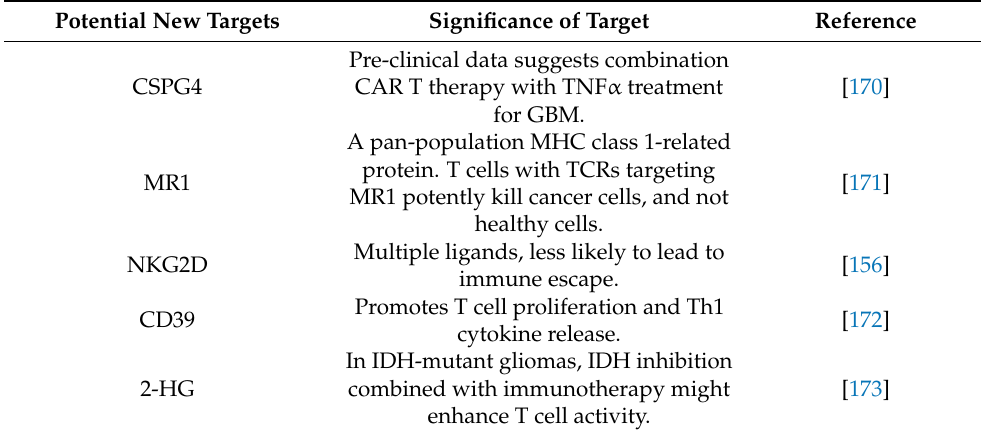
Table 3. Experimental targets for future GBM cancer